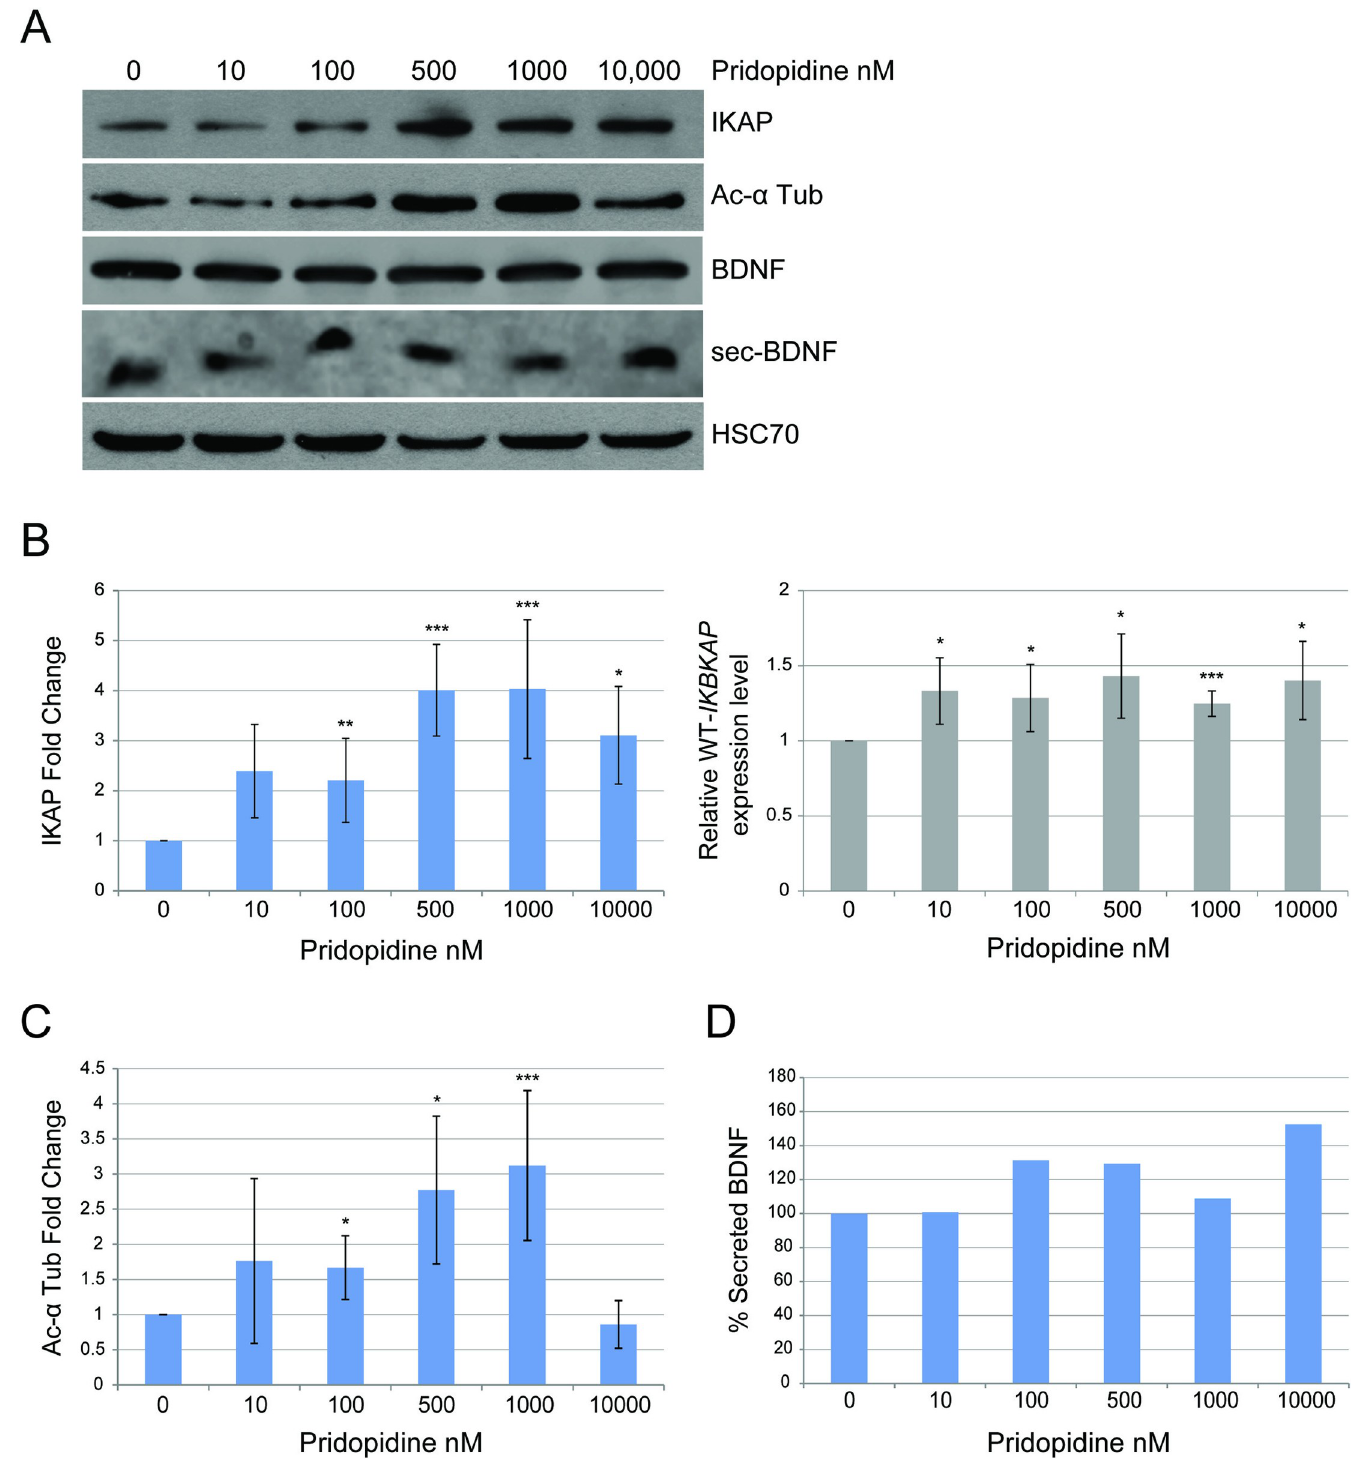
Fig 2. Pridopidine elevates IKAP protein level and affects acetylated α -tubulin levels and BDNF secretion in FD cells. (A-D) FD cells were treated with 0, 10, 100, 500, 1000, and 10,000 nM of pridopidine. Control treatment was done with vehicle only. (A) Western blotting of FD cell lysates with and without pridopidine treatment for 10 days. Blot was probed using anti-IKAP, anti-acetylated α -tubulin, anti-BDNF, and anti-HSC-70 antibodies. HSC-70 was analyzed as a protein-loading control. (B) Left panel: Fold change levels of IKAP relative to control analyzed after a 10-day treatment; levels were normalized to HSC70. Right panel: IKBKAP expression levels relative to control analyzed by qRT-PCR from RNA extracted from FD cells after 5 days of treatment. (C) Fold change levels of acetylated α -tubulin relative to control